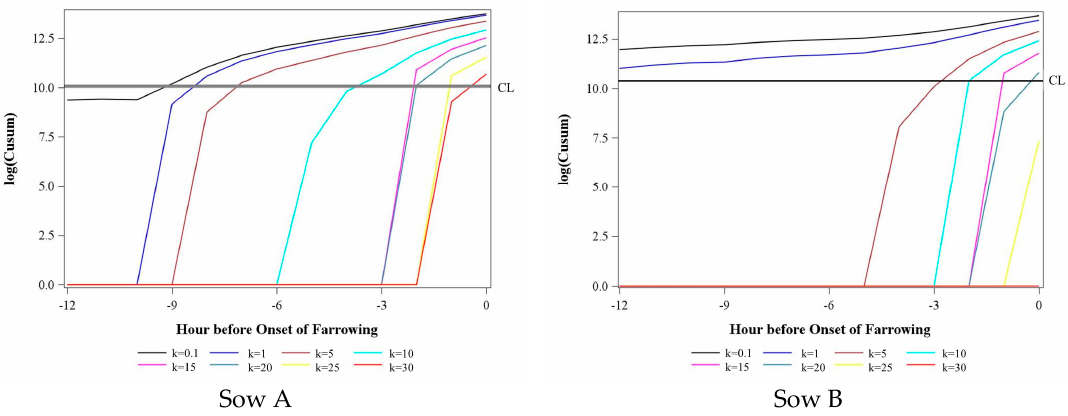
Figure 7. Influence of the k value on the alarm time (Chart exceeds control limit (CL)) of the CUSUM chart ( h = 4) exemplarily for two sows and the acceleration index 1st variation and the distribution characteristic CumDi with the time interval of 60 min and a range of the moving average of 1. Note that, for a better presentation, the CUSUM statistic is transformed on a log scale.